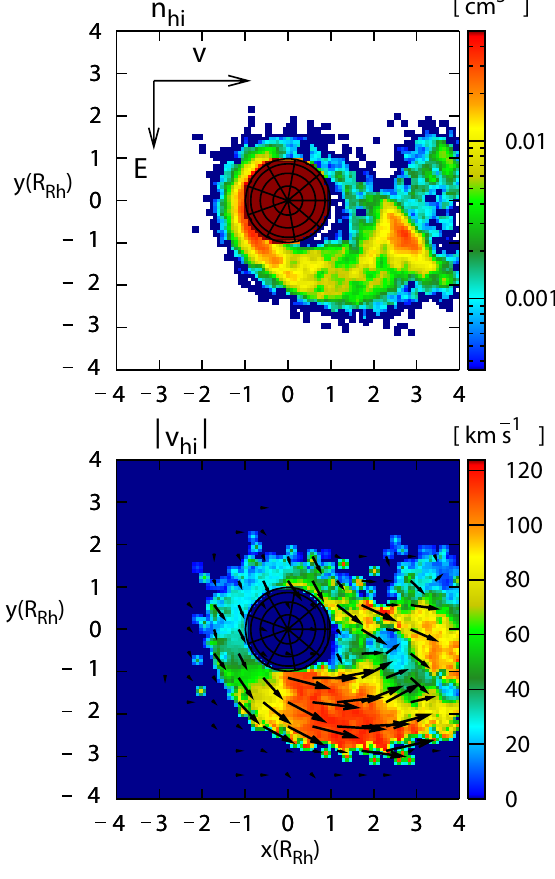
Fig. 12. Illustration of the density (top) and velocity (bottom) of escaping heavy ions from a weak exosphere of Rhea. The plots shown are cuts through the equatorial plane of Rhea (xy-plane). The direction of the upstream plasma velocity and corotational electric field are shown on the top panel. Note that for this test run, Rhea was at the center of the simulation box. Here the heavy ion mass was chosen to be 17 amu and the exospheric scale height was set to 100 km.